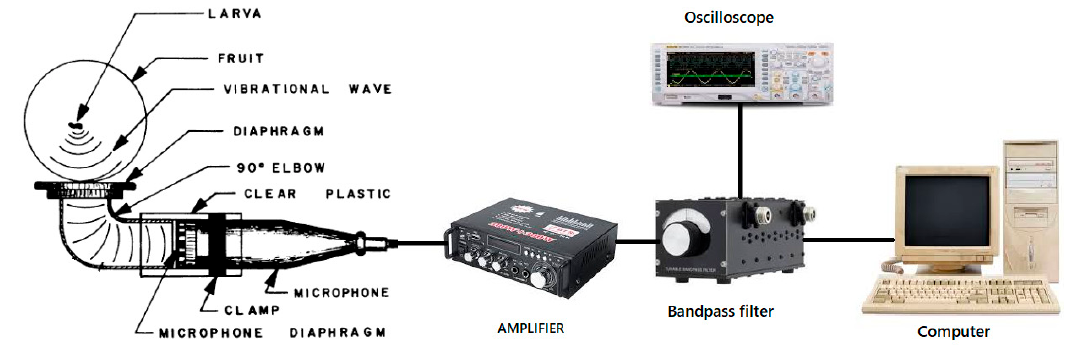
Figure 7. A typical acoustic emission system (Adapted from Litzkow et al.